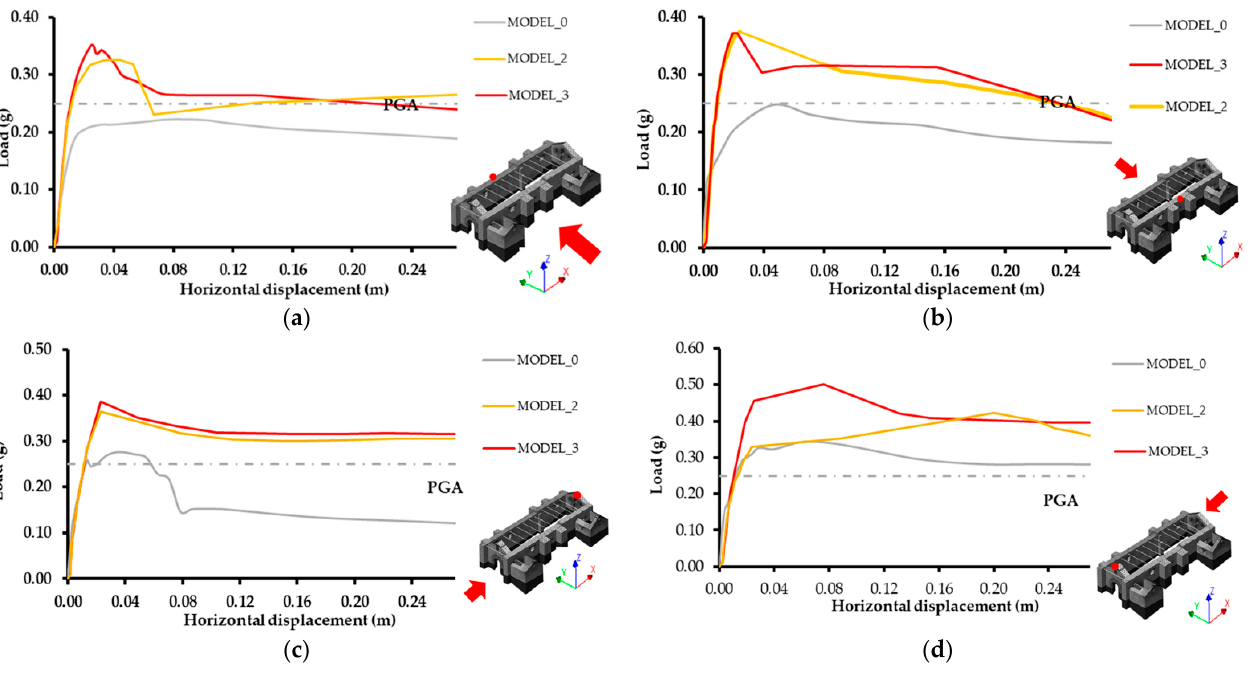
Figure 18. Pushover curves of Models 0, 2 and 3 in ( a ) +YY, ( b ) − YY, ( c ) +XX and ( d ) − XX directions. Note that the displacements in the pushover curves correspond to the displacements of the control nodal points, indicated here with red dots.